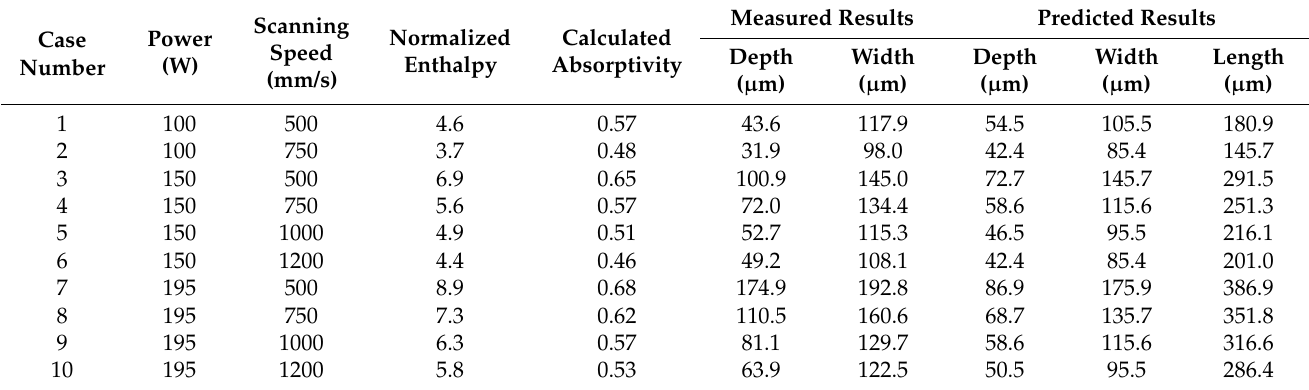
Table 1. Comparison between experimental [22] and predicted molten pool size of